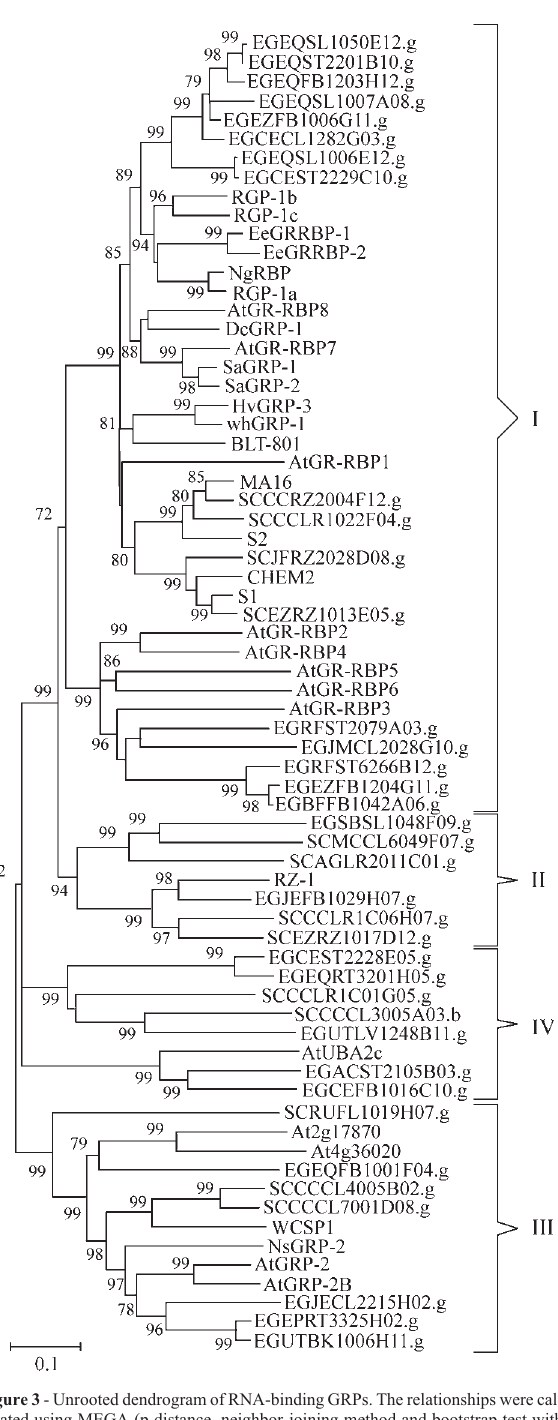
Figure3 -UnrooteddendrogramofRNA-bindingGRPs.Therelationshipswerecal- culated using MEGA (p distance, neighbor-joining method and bootstrap test with 5000 replications, pairwise deletions). The analysis was performed based on the ClustalW alignment of the sequences. Accession numbers: MA16 (P10979), S1 (S12311), S2 (S12312), CHEM2 (CAA43431), Hv GRP-3 (Z48624), WhGRP-1 (U32310), BLT-801 (S71453), Sa GRP-1 (L31374), Sa GRP-2 (L31377), CCR1 (Q03251), CCR2 (Z14987), Dc GRP-1 (X58146), GRRBP-1 (AAC61786), GRRBP-2 (AAC61787), Ng RBP (AF005359), RGP-1a (D16204), RGP-1b (D16205), RGP-1c (D16206), RZ-1 (D28861), Ns GRP-2 (CAA42622), At GRP-2 (S47408), AtGRP2b (Q38896), At2g17870 (Q94C69), WCSP1 (BAB78536), AtGR-RBP1 (AAD22311), AtGR-RBP2 (CAB36849), AtGR-RBP3 (BAB10366), AtGR-RBP4 (BAB03001), AtGR-RBP5 (AAG52402), AtGR-RBP6 (AAF98412), AtGR-RBP7 (AAD23639), AtGR-RBP8 (CAB43641). Sugarcane sequences are represented using SUCEST nomenclature (Fusaro et al. , 2001). Romans numerals represent the different sub-classes of RNA-binding